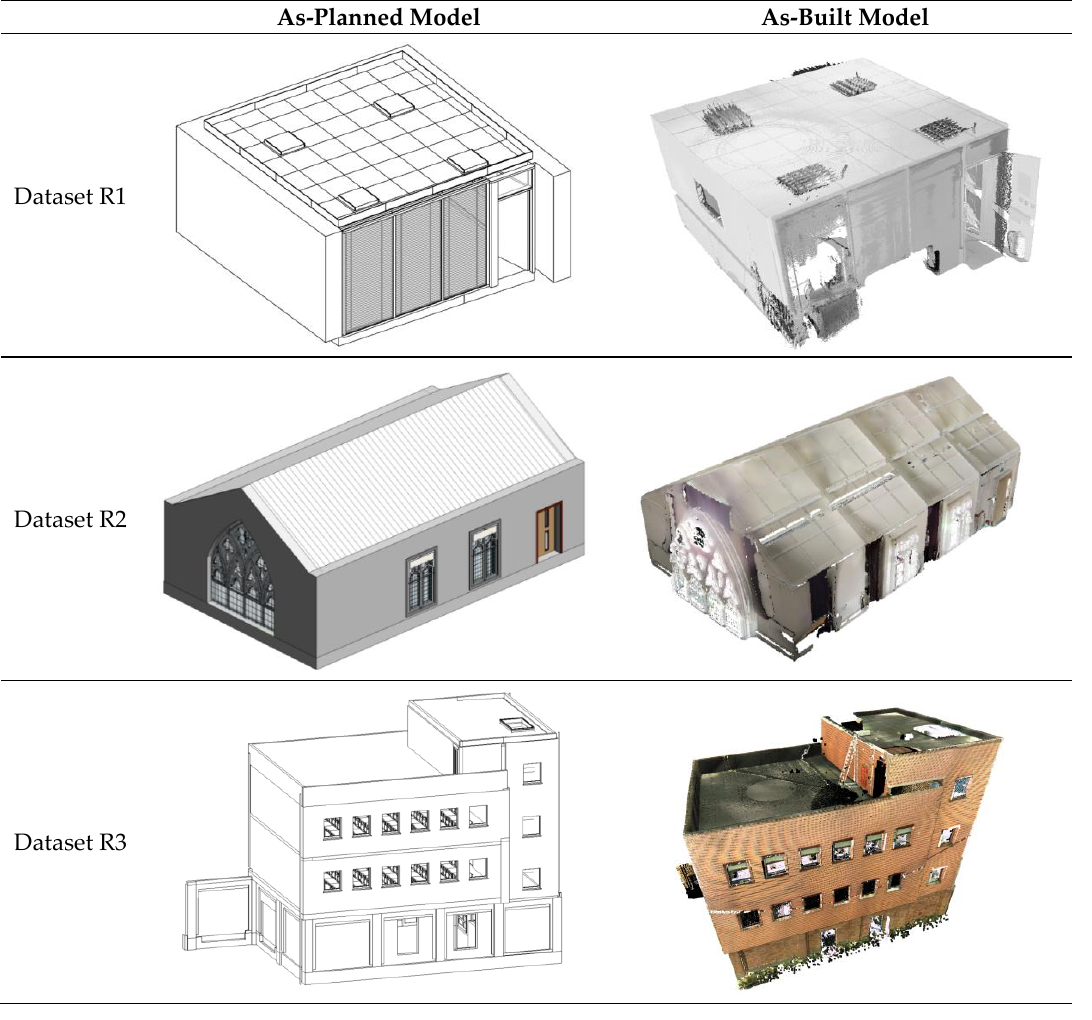
Figure 12. Visualization of BIM (as-planned model) and scan (as-built model) from dataset R1, R2, and R3. Table 2. Registration details of all the datasets, including the computation of the correct rotation matrix and identical